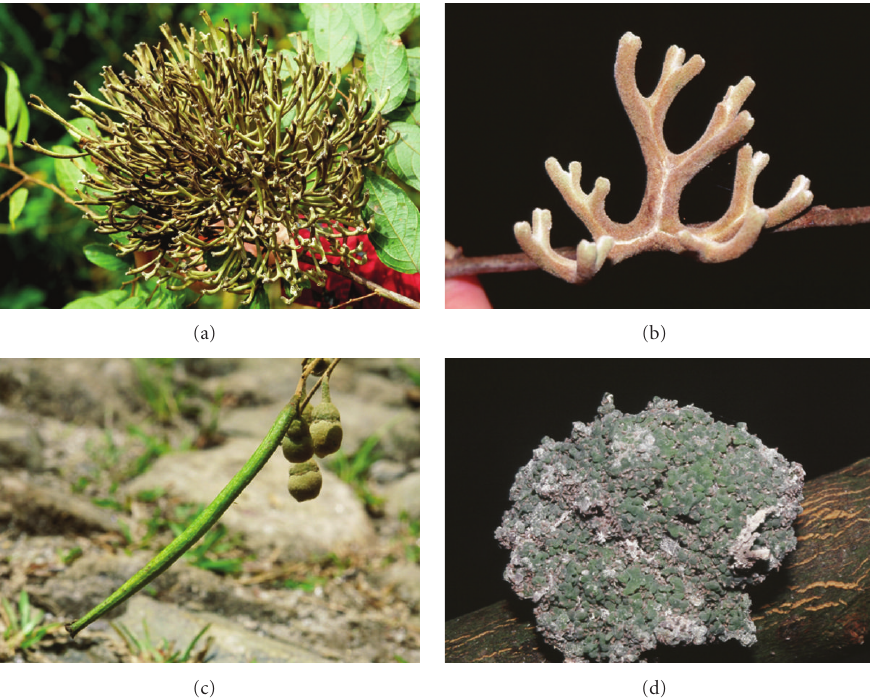
Figure 7: (a) A mature, well-ramified gall of Cerataphis vandermeermohri on Styrax subpaniculatus (Urung Tama, Sumatra; 12 September 1993). (b) A young gall of C. vandermeermohri on S. subpaniculatus , indicating that the ramified gall has a single cavity (Bandar Baru, Sumatra; 4 August 1996). (c) A tubular gall of Tuberaphis leeuweni on S. subpaniculatus and fruits of the host tree (Mt Sibayak, Sumatra; 19 September 1993). (d) A gall of Tuberaphis takenouchii on Styrax formosanus (upside down under natural conditions; Habon, Taiwan; 22 July